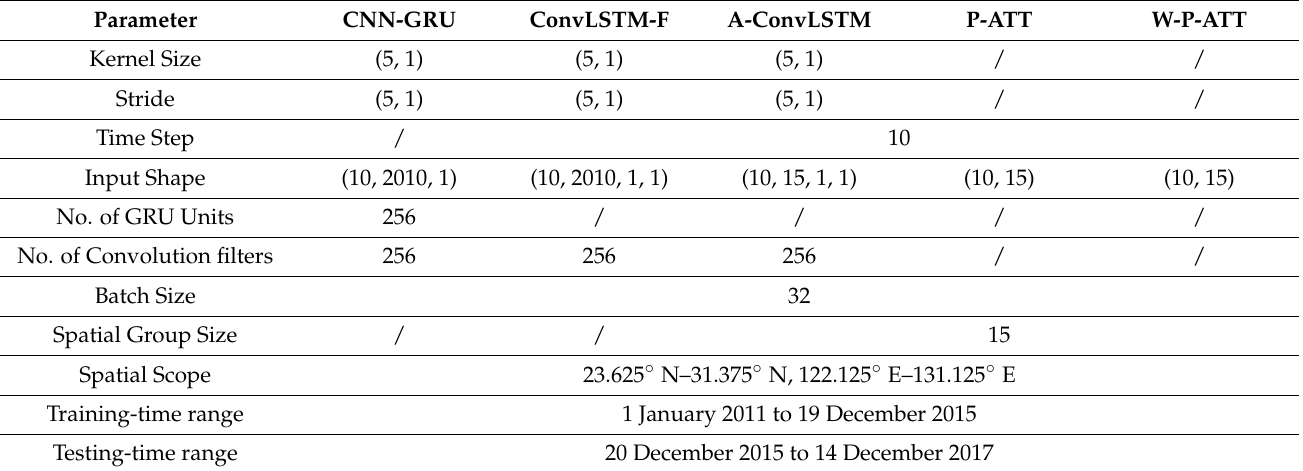
Table 1. The detailed information of the